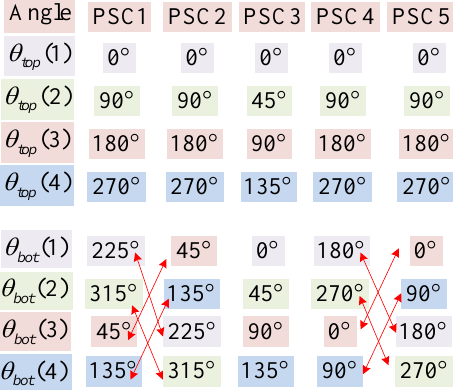
Figure 7. Carrier angles of each SM for five PSC-SPWM schemes when N =